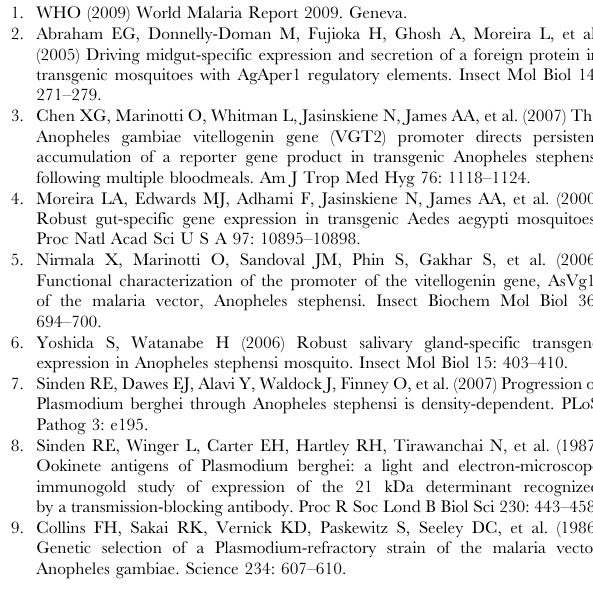
Figure S1 Generation and analysis of transgenic A.gam- biae line AgPB1. A: map of transformation vector pPBLuc.